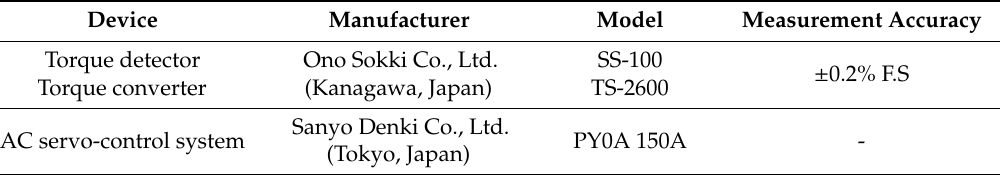
Figure 7. Schematic of the torque-measurement system used in the WLT performance tests. Table 2. Torque transducer and AC servo-control system.